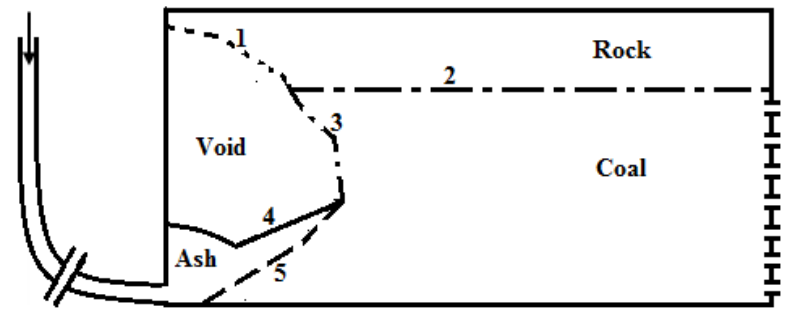
Figure 47. Probabilistic simulation of the UCG process by possibility of movement of the following interfaces: 1.void-rock; 2. coal-rock; 3. void-coal; 4.void-ash; 5. ash-void [92].